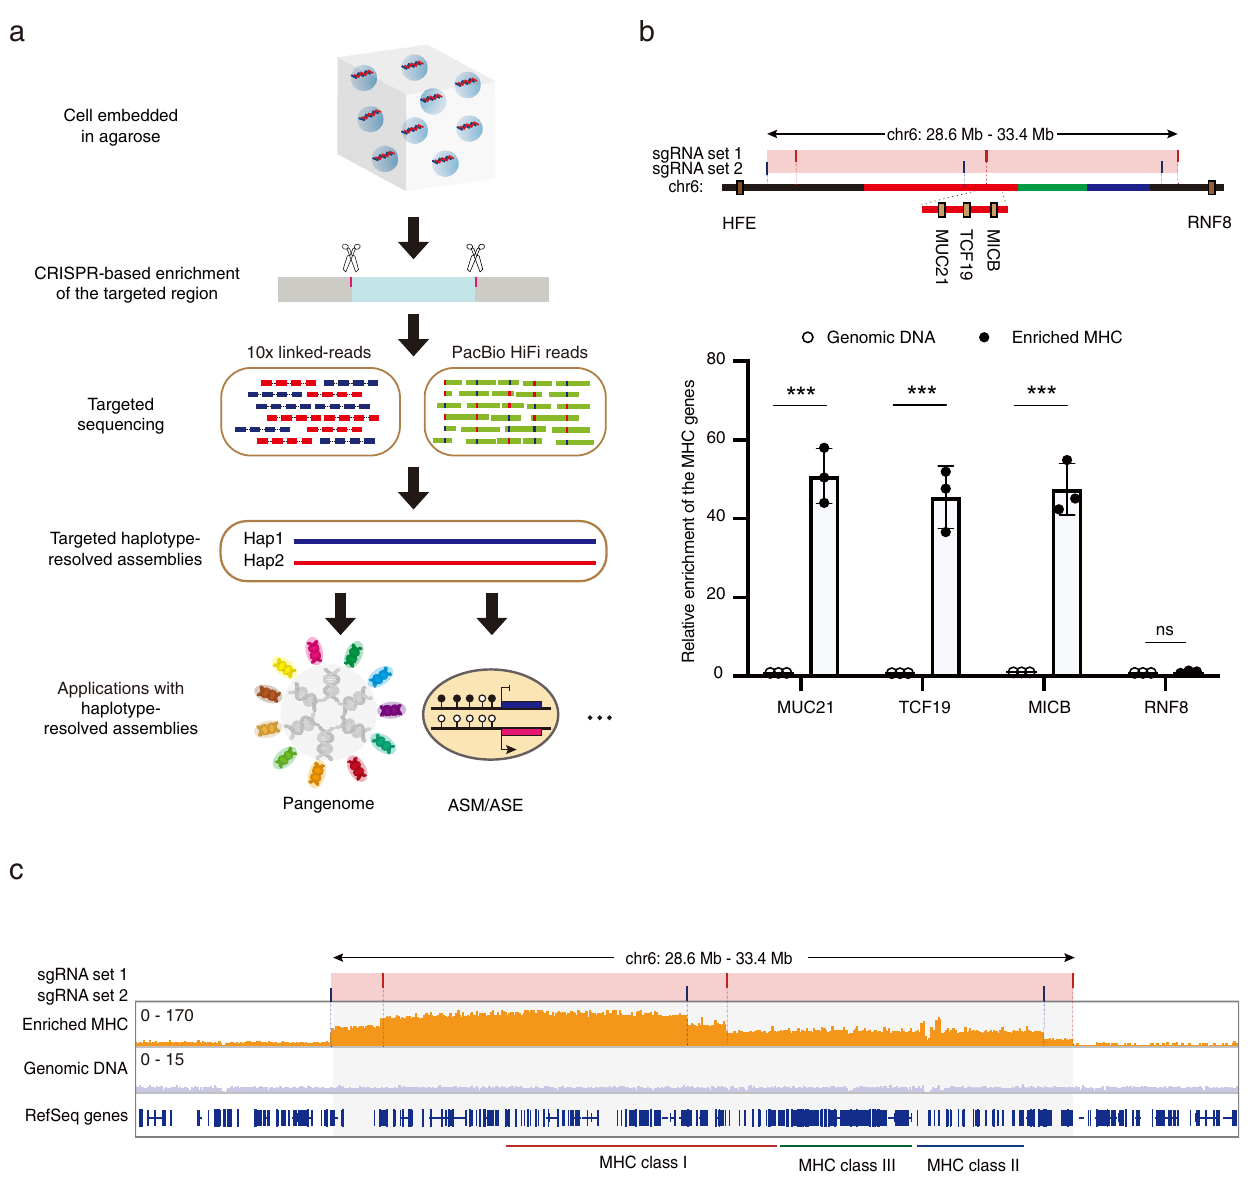
Fig. 1 | CRISPR-based targeted enrichment of the MHC region. a Schematics of CRISPR-based targeted haplotype-resolved assembly of the target region. Cells were embedded in agarose plugs and the targeted region was then enriched by combining CRISPR-based in-gel digestion with pulsed- fi eld gel electrophoresis. Enriched HMW DNA molecules were subjected to both 10x Genomics linked-read and the PacBio HiFi long-read sequencing. A highly reliable set of phased hetero- zygous variants wascalled and usedto separate the HiFi reads into two haplotype- partitioned read sets, from which haplotype-resolved assembly of the targeted region was constructed. The targeted assembled personal haplotypes can be fur- ther used in the downstream analyses. b QPCR analyses showed signi fi cant enrichment of the targeted MHC region. Top part: the positions of two sets of sgRNAstargetingtheMHCregion.ThepinkbarindicatesthetargetedMHCregion. The red, green, and blue lines indicate the regions for the HLA class I, class III, and